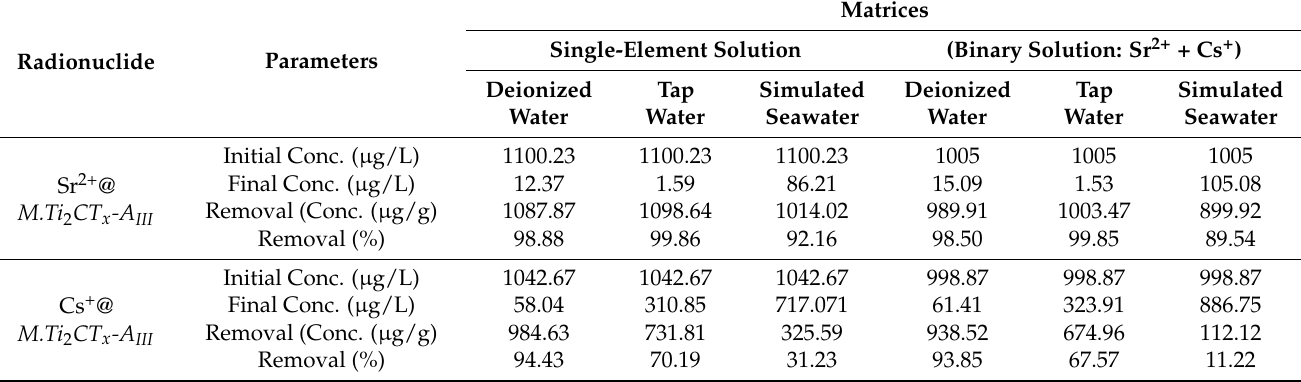
Table 5. Radionuclide Sr 2+ and Cs + removal in various matrices using the synthesized magnetic